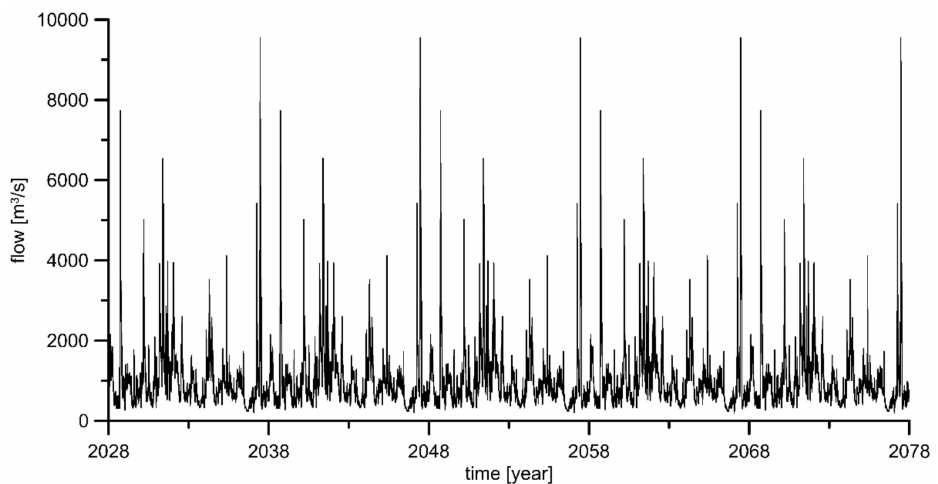
Figure 2. The change in the volume of flow through Włocławek Barrage in the period 1 January 2028–31 December 2078 adopted for the scenario